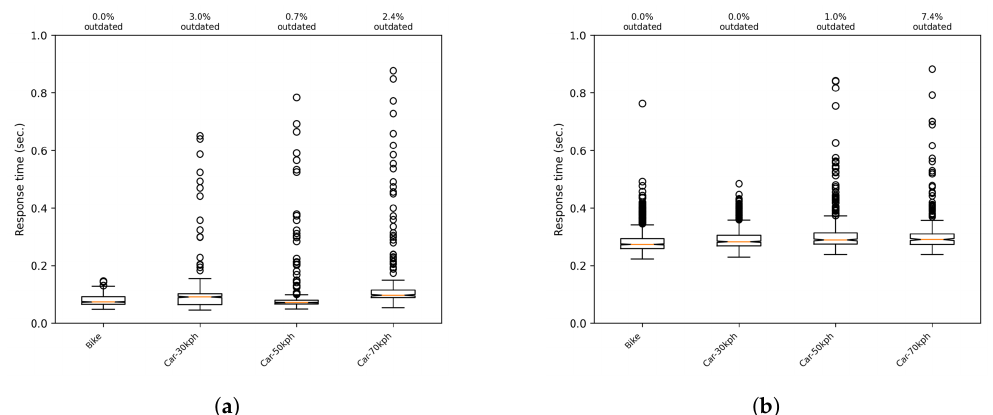
Figure 7. Response times for phones moving at different speeds with the UDP and HTTP communi- cations versions. ( a ) UDP; ( b ) HTTP.